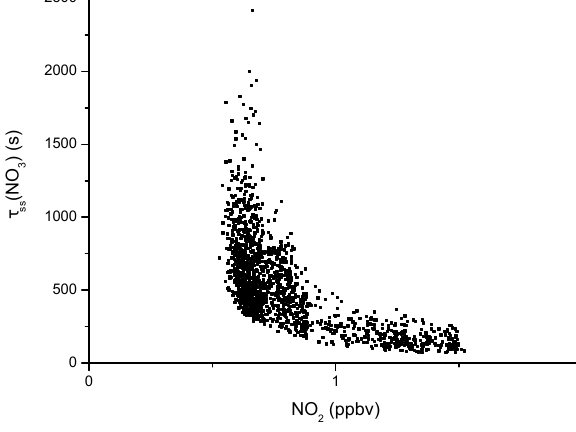
Fig. 5. Dependence of NO 3 lifetime, τ ss (NO 3 ), on NO 2 mixing ra- tios (night 6–7 December). The NO 3 lifetime was calculated using K 2 and measurements of N 2 O 5 , NO 2 and O 3 (Eq.